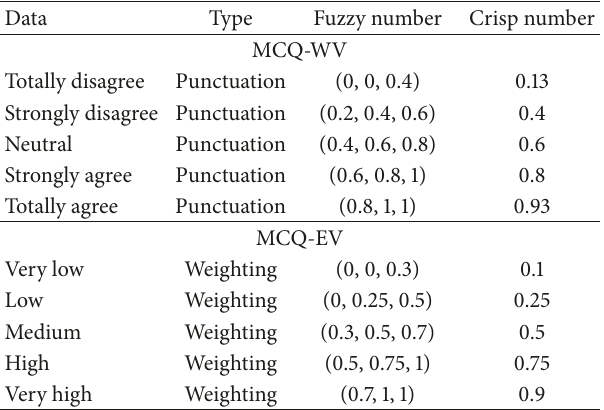
Table 3: Correspondence among linguistic terms, fuzzy numbers, and crisp numbers for the MCQ-WV and MCQ-EV